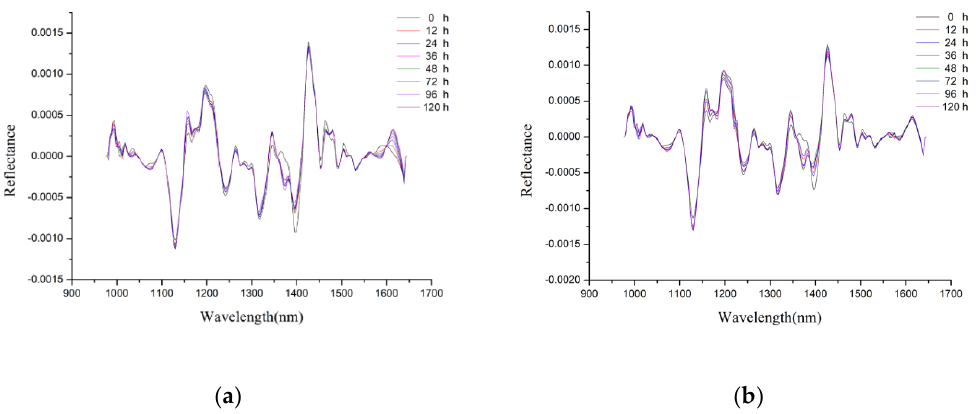
Figure 2. Average spectra preprocessed by second-order derivative: ( a ) Maize 1; ( b ) Maize 2. Spectral differences of maize kernels under different aging duration time at certain wavelengths could be observed.